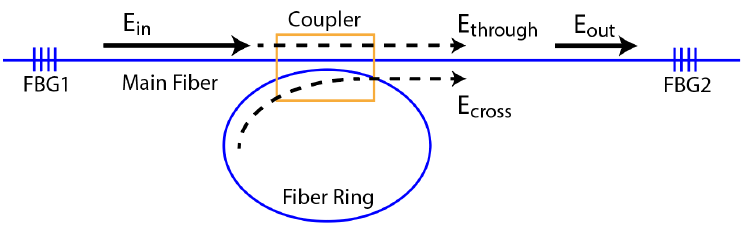
Figure 3. Schematic of the wave flow in FRR for a standard single-mode fiber ring.